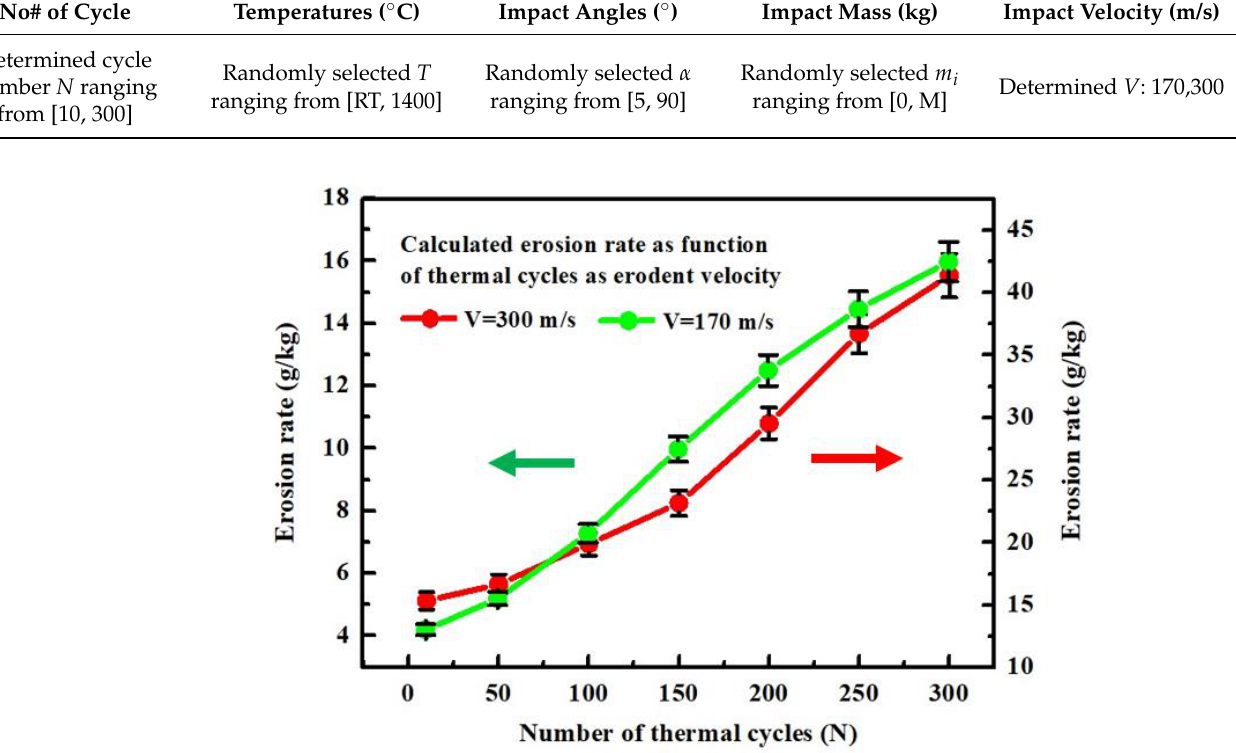
Table 7. Parameters used to calculate erosion rates under different impact